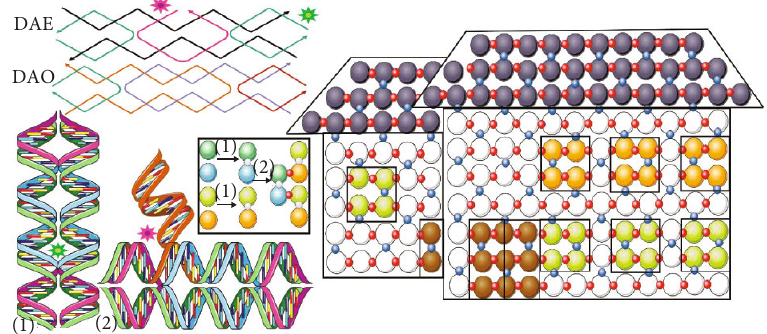
Figure 3: The process of the two-dimension structures constructed by DAE and DAO